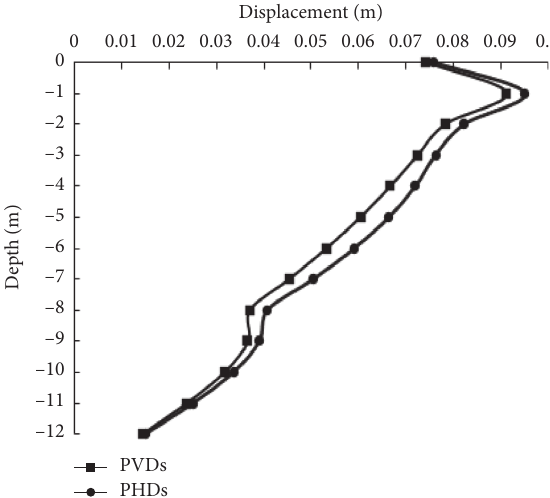
Figure 9: Relationship curve between horizontal displacement and time.